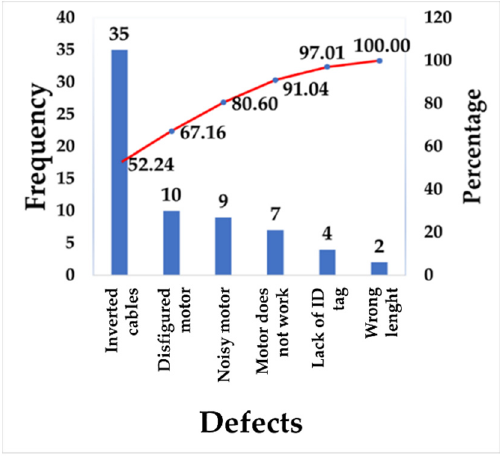
Figure 5. Pareto diagram of cable assembly defects.